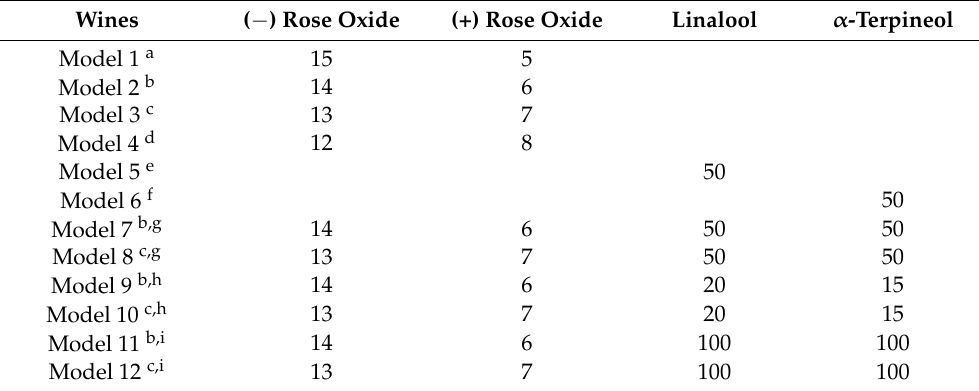
Table 1. Concentrations ( µ g/L) of Terpenes in each